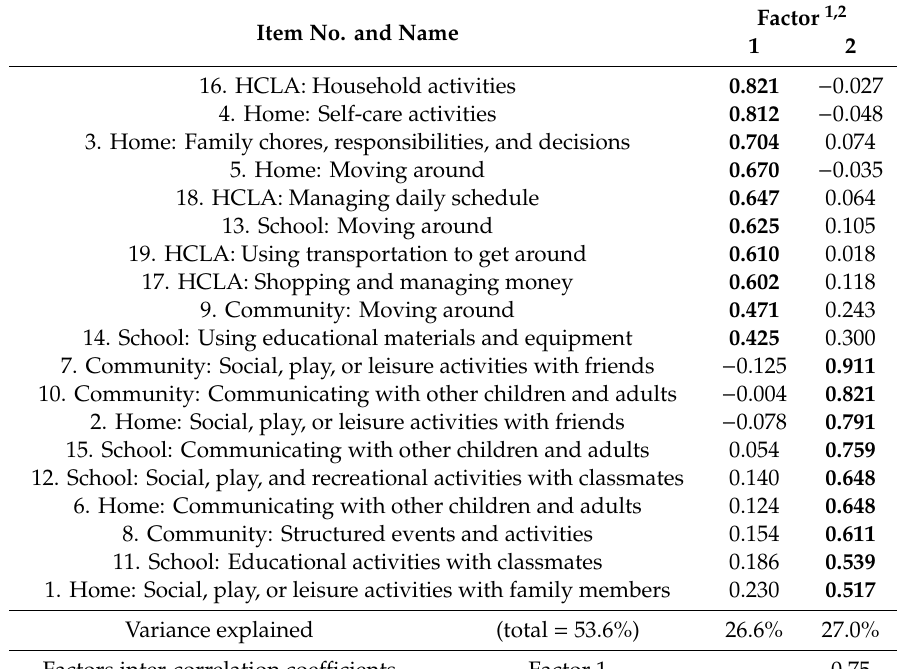
Table 4. Factor loadings of the independence dimension of FUNDES-Child by exploratory factor analysis ( n =